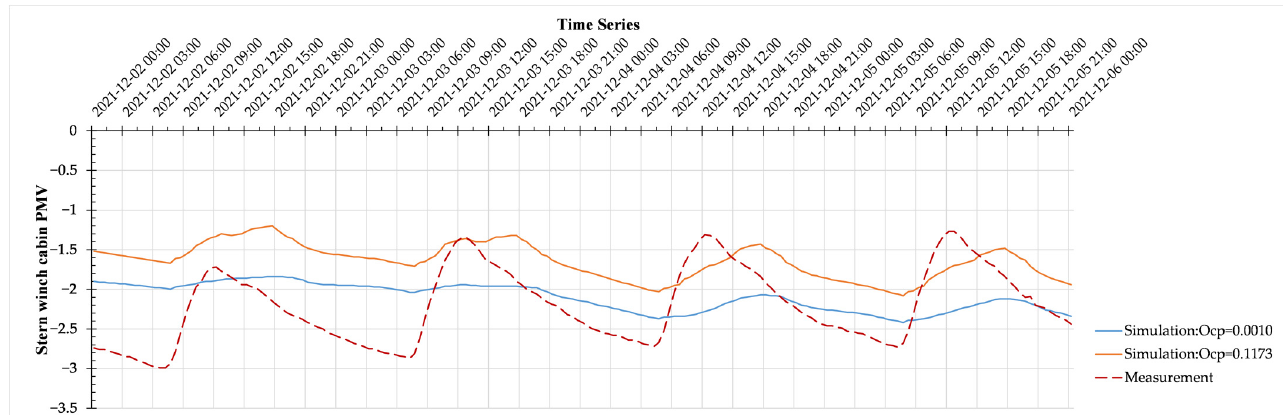
Figure B3. Stern winch cabin: predicted mean vote between 2 and 5 December 2021